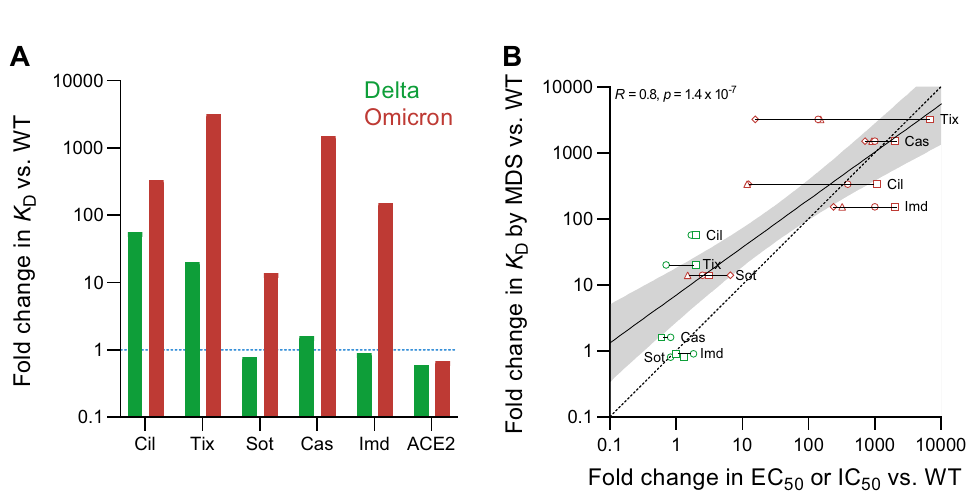
Figure 3. ( A ) Affinity ( K D ) changes of therapeutic COVID-19 antibodies and ACE2 in the presence of Delta (green) and Omicron BA.1 (red) spike RBDs as compared with wild type RBD. ( B ) K D changes of therapeutic COVID-19 antibodies correlated with their published half-maximal effective concentrations (EC 50 ) or half-maximal inhibitory concentrations (IC 50 ) of focus reduction neutralization tests (FRNT; active virus) or pseudovirus neutralization tests (PNT), respectively. Triangles and diamonds are FRNTs using VERO- TMPRSS2 and VERO-hACE2-TMPRSS2 cells, respectively, taken from VanBlargan et al. 7 . Squares and circles are PNTs taken from Cao et al. 5 and Liu et al. 6 , respectively. The solid line is a linear regression with the gray area indicating the 95% confidence intervals, R the Pearson’s correlation coefficient and the p -value demonstrating statistical significance. The dashed line indicates the ideal scenario of change in K D being equal to change in EC 50 or IC 50 .